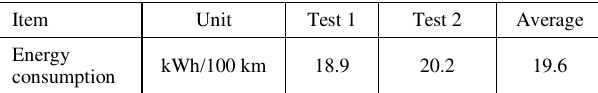
Table 6. Energy consumption by an electric passenger car on a route set for the purpose of an RDE